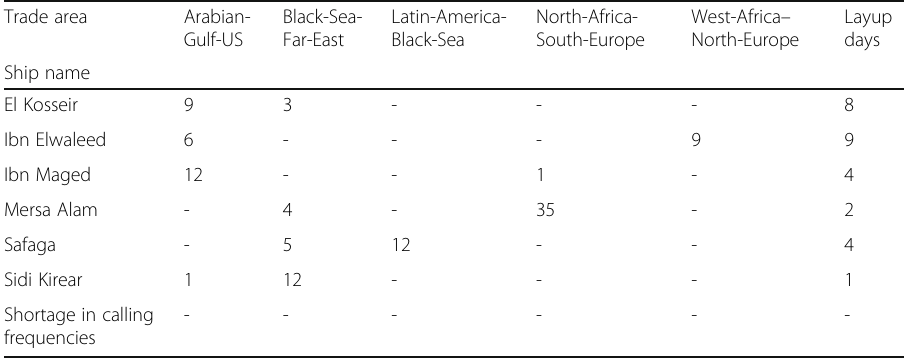
Table 16 Optimal fleet calling frequencies in 2018, after improvement, classified by ship and trade area Trade